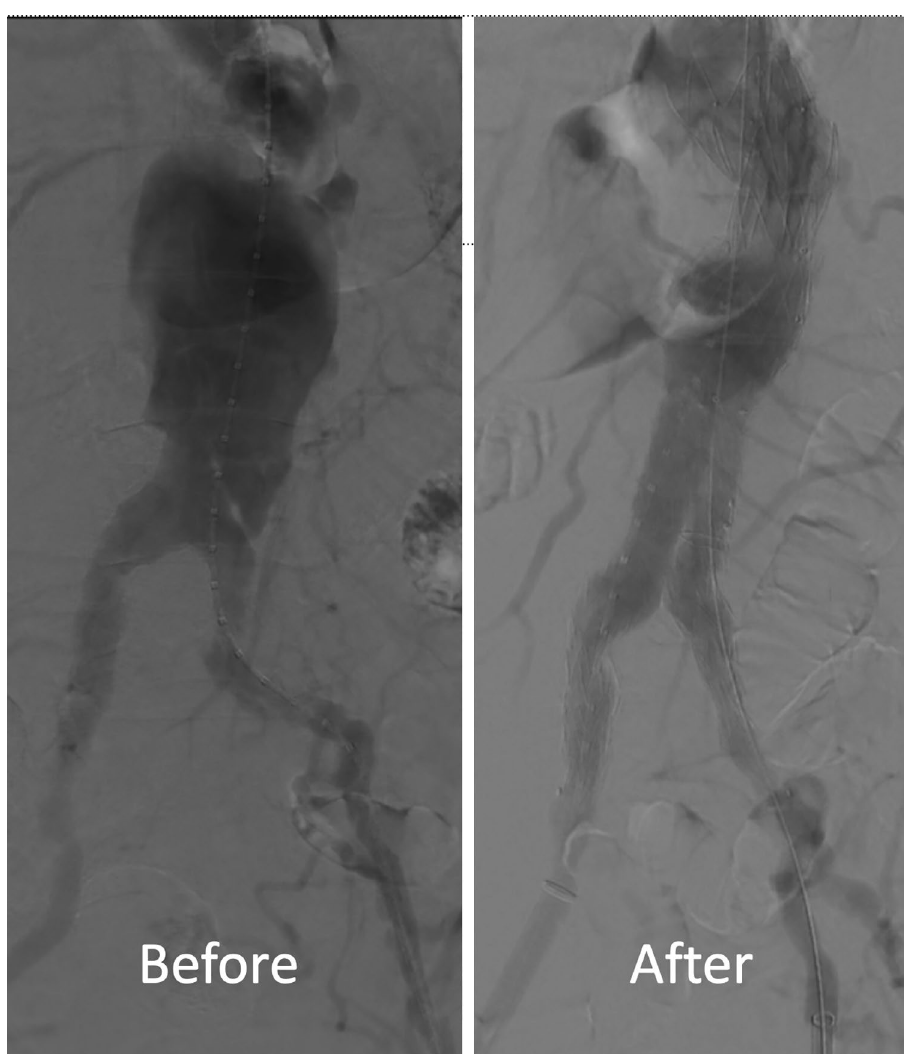
Fig. 5 Pre- and post-EVAR angiogram with digital subtrac-